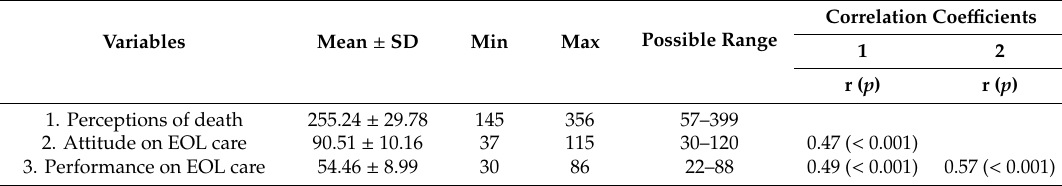
Table 2. Descriptive Statistics and Correlations Among Perceptions of Death, Attitude and Self-reported Performance on EOL Care of Hospital Nurses. ( N = 230).